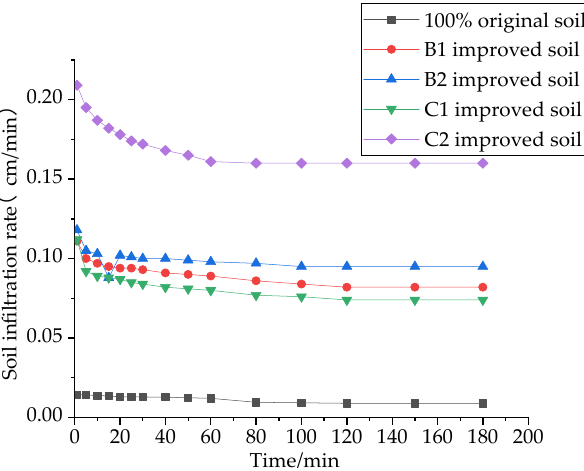
Figure 7. Effect of ameliorants on the soil infiltration rate.